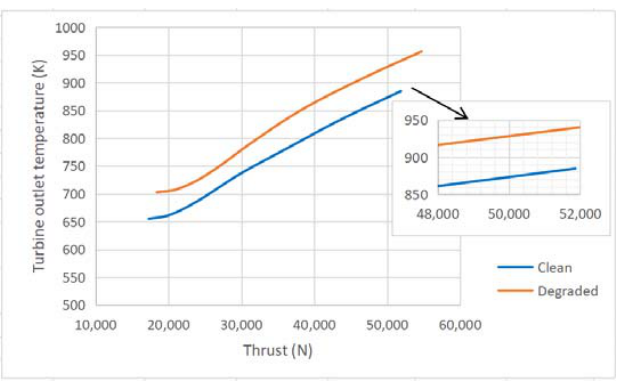
Figure 21. Comparison of the fuel flow to turbine temperature relationship between a clean engine and degraded engine.